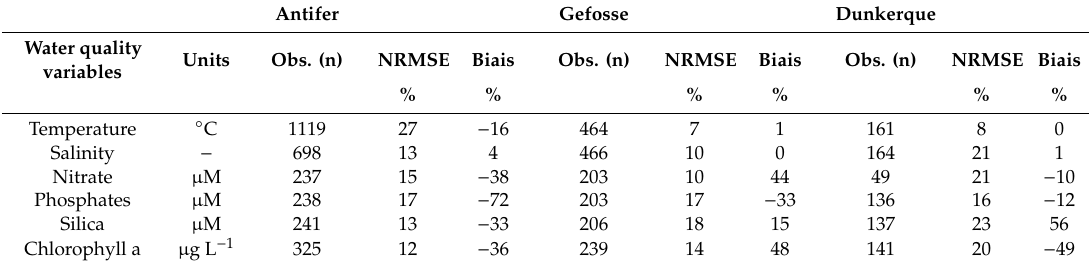
Table 6. Evaluation of ECO-MARS3D performance for the coastal zone stations (Antifer, Gefosse, Dunkerque). The goodness of fit of the simulations with respect to the observed concentrations (Obs.) was evaluated for the major water quality variables by calculating the root mean square error normalised to the range of the observed data (NRMSE), according to the formula observations). The NRMSE represents a percentage of variation. The relative bias is calculated as